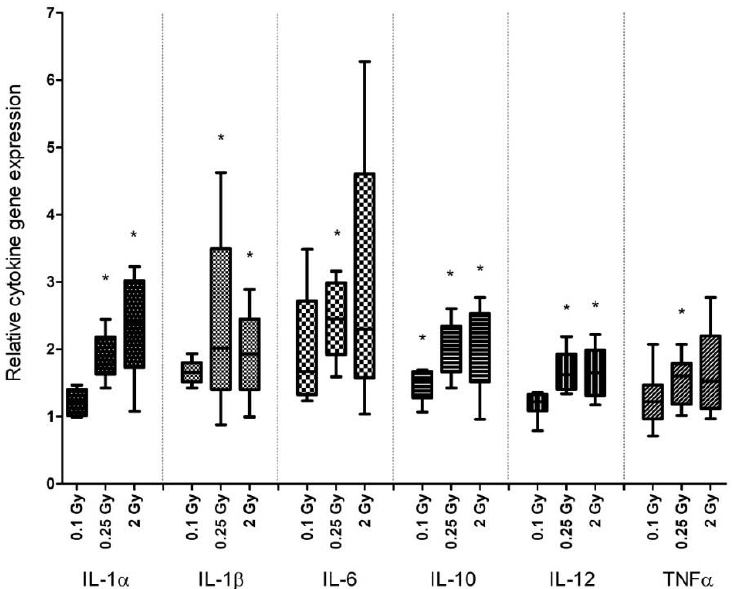
Figure 3. Alterations of cytokine gene expression patterns in splenic DCs after irradiation. Splenic DCs from total-body irradiated mice were separated by magnetic cell sorting, RNA was isolated and the relative expression of the specified cytokines was quantified by quantitative RT-PCR (qRT-PCR) as described in Materials and Methods. The figure shows relative changes in gene expression. Data represent the average of 5 independent experiments, with bars indicating mean ± SD. Significance was tested by Student’s t -test (* p < 0.05).